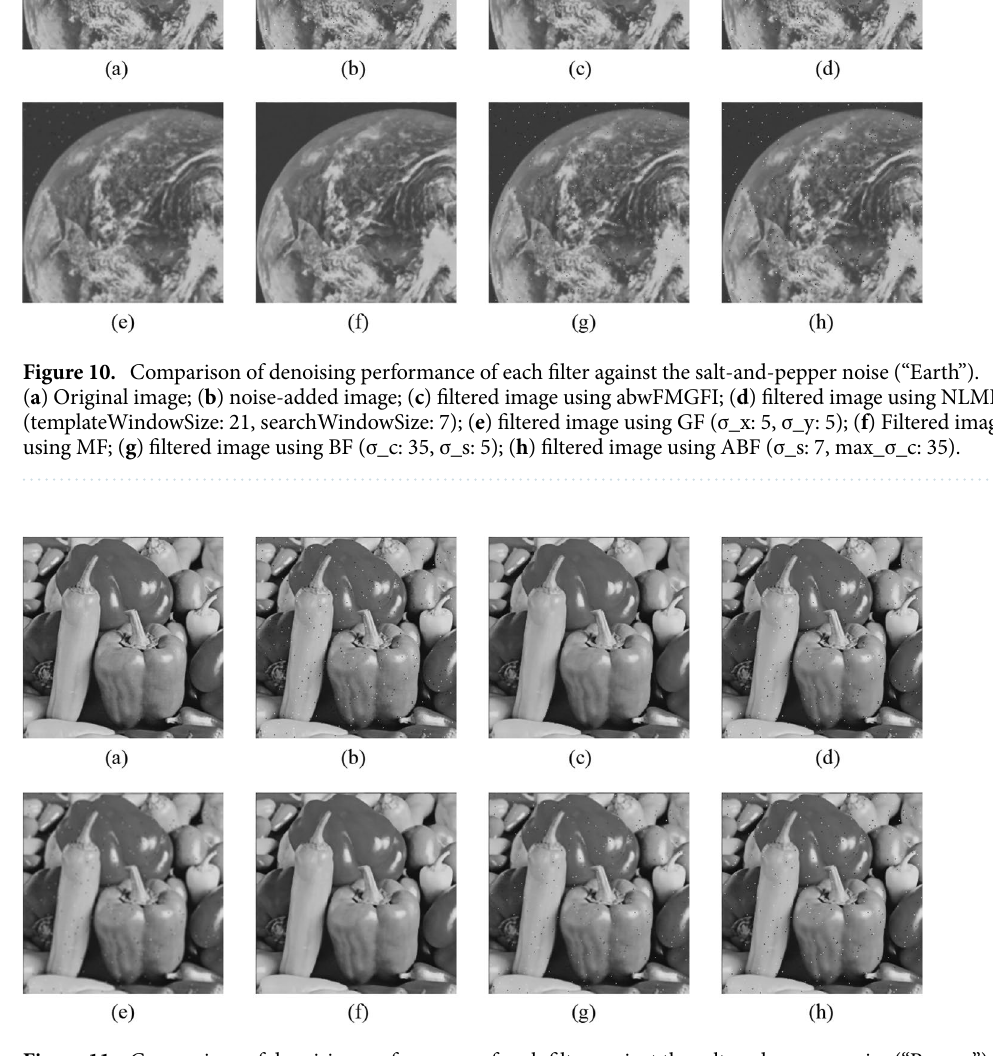
Figure 11. Comparison of denoising performance of each filter against the salt-and-pepper noise (“Pepper”). ( a ) Original image; ( b ) noise-added image; ( c ) filtered image using abwFMGFI; ( d ) filtered image using NLMF (templateWindowSize: 21, searchWindowSize: 7); ( e ) filtered image using GF (σ_x: 5, σ_y: 5); ( f ) filtered image using MF; ( g ) filtered image using BF (σ_c: 35, σ_s: 5); ( h ) filtered image using ABF (σ_s: 7, max_σ_c: 35).